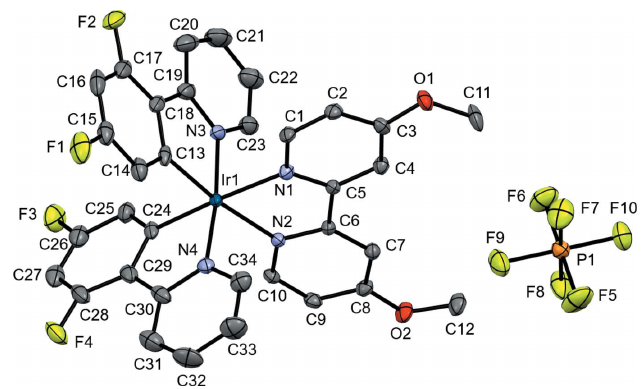
Figure 1 The structures of the molecular components of the title compound shown as 50% probability ellipsoids. Hydrogen atoms have been omitted for